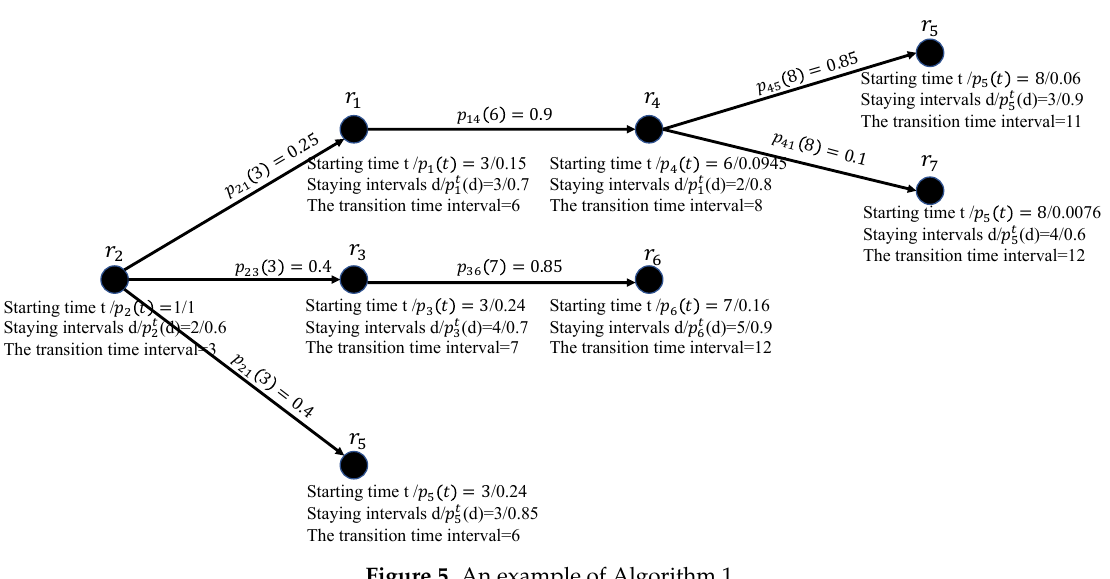
Figure 5. An example of Algorithm 1.